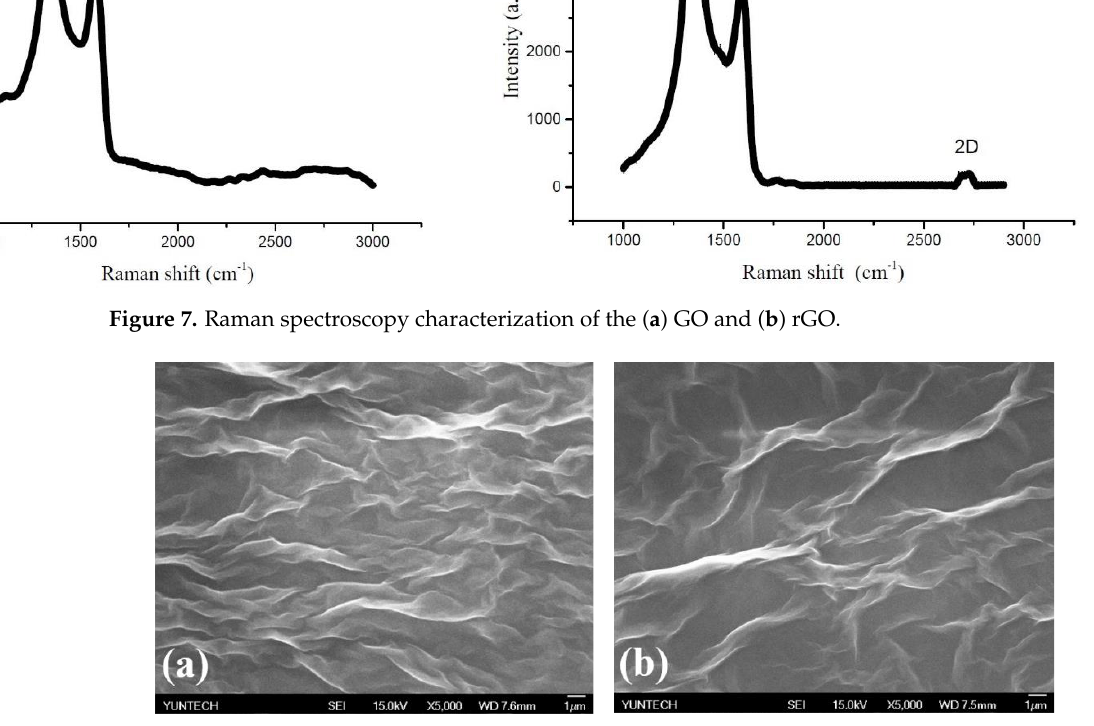
Figure 8. FE-SEM image of ( a ) the GO sheets and ( b ) the rGO sheets at 5000x magnification